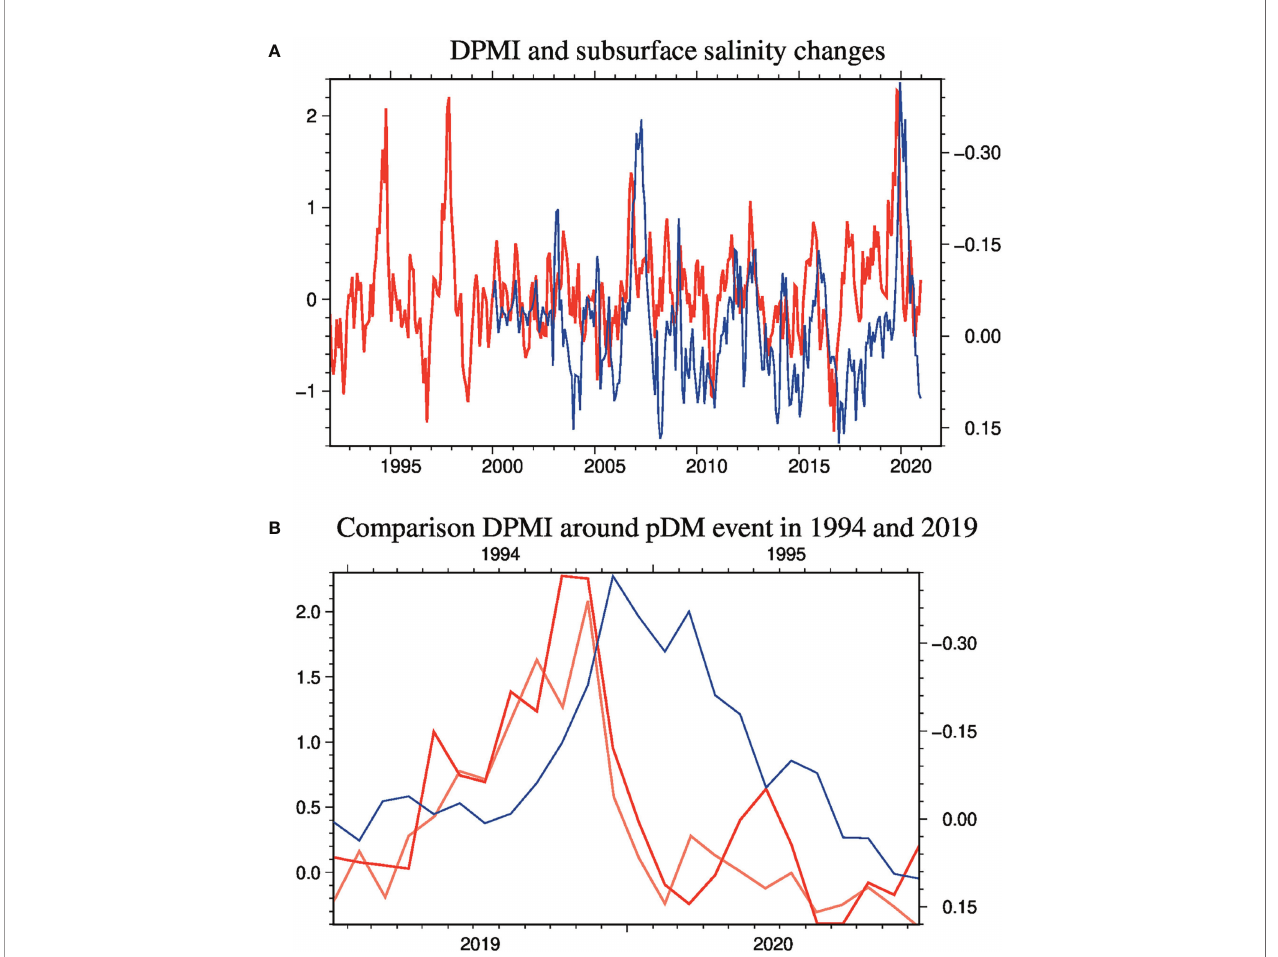
FIGURE 7 | Dipole mode index (DMI; red) and salinity (blue) variabilities in the subsurface layers (25.0 g ) at 5°S, 80°E from 1992 to 2000 (A) and comparison of the temporal changes in DMI (red) and salinity (blue) during the pIOD in 2019 with those in DMI (pink) during the pIOD in 1994 (B) . The temporal changes in salinity were based on the Argo gridded dataset. DMI is de fi ned as the SST anomaly difference between the regions of 50°E – 70°E, 10°S – 10°N and 90°E – 110°E, 10°S – 0° (Saji et al., 1999) based on NOAA OI SSTv2 (Reynolds et al.,